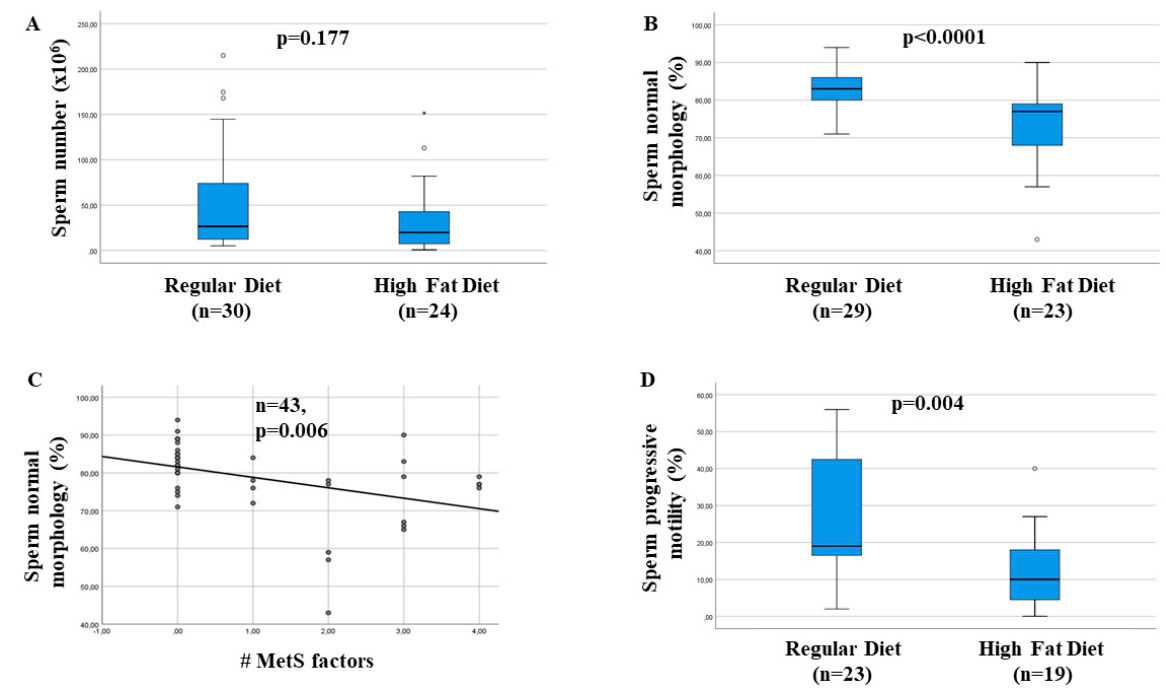
Figure 5. Effect of feeding rabbits a high-fat diet (HFD) on sperm number ( A ), sperm normal morphology ( B ) and sperm progressive motility ( D ). ( C ) shows the association between increasing number (#) of metabolic syndrome (MetS) components and sperm normal morphology. Numbers of animals examined ( n ), along with level of significance ( p value) of the statistical analyses performed are also reported. * and °, outlier cases.